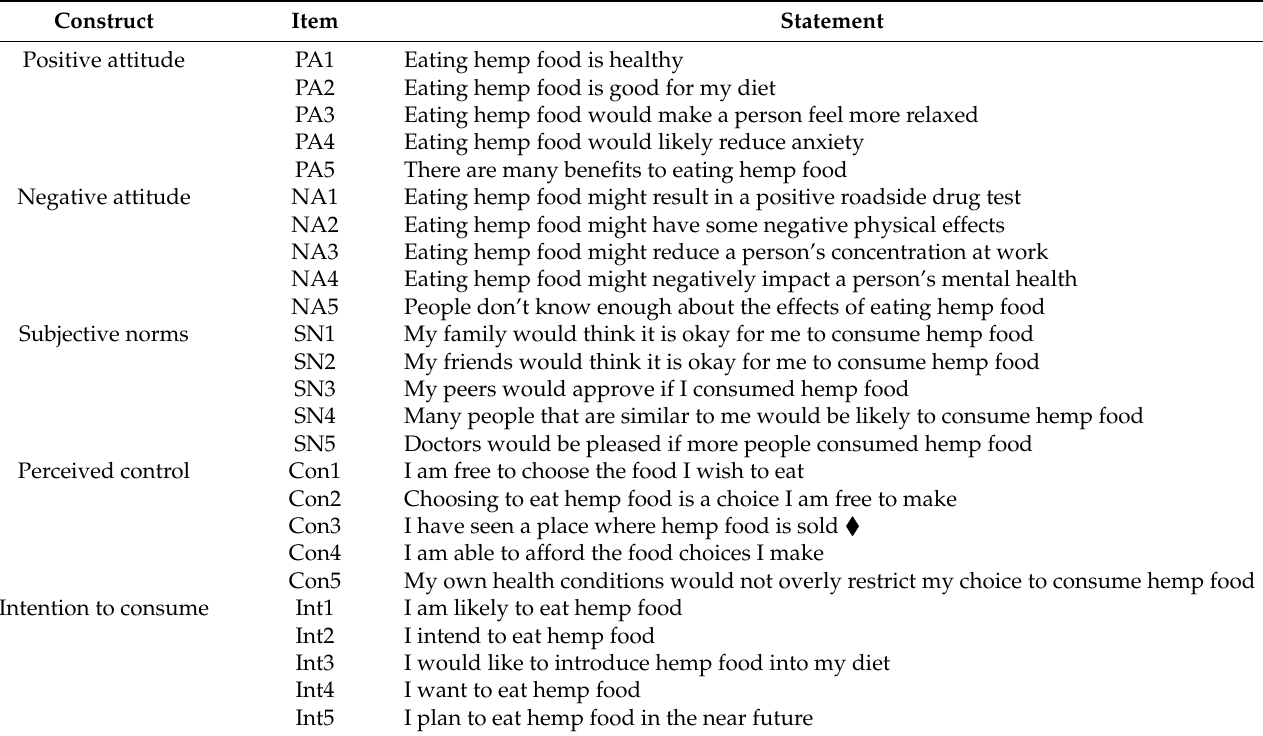
Table 4. Theory of Planned Behaviour response items by construct